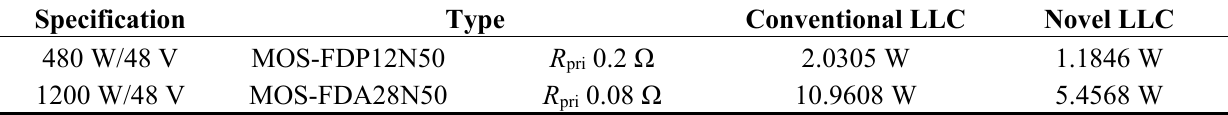
Table 2. Overall power loss at